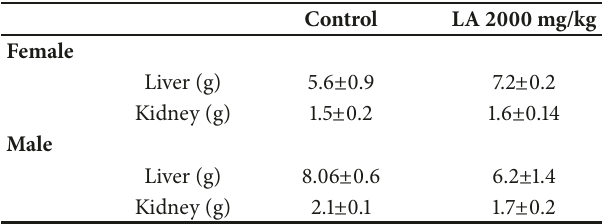
Table 6: Effect of L. angustifolia EO on biochemical parameters of orally treated